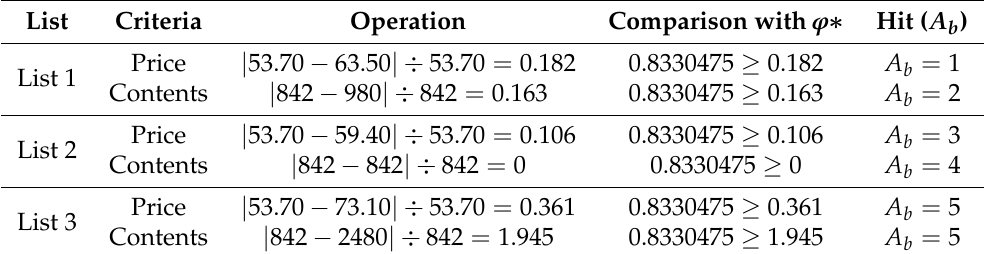
Table 21. Substitution of values in Equation